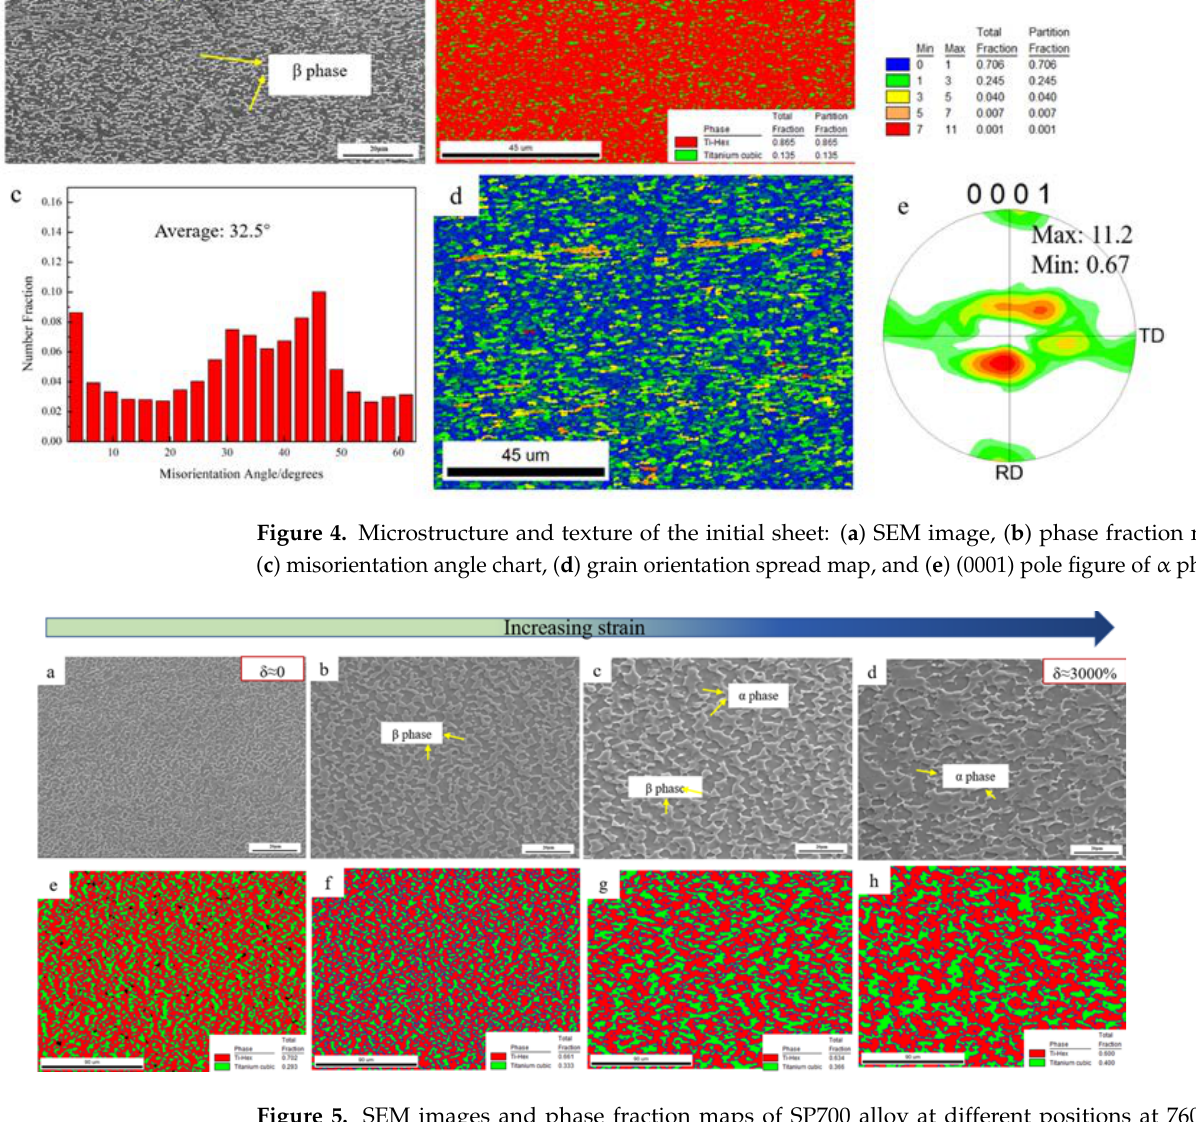
Figure 4. Microstructure and texture of the initial sheet: ( a ) SEM image, ( b ) phase fraction map, ( c ) misorientation angle chart, ( d ) grain orientation spread map, and ( e ) (0001) pole figure of α phase.